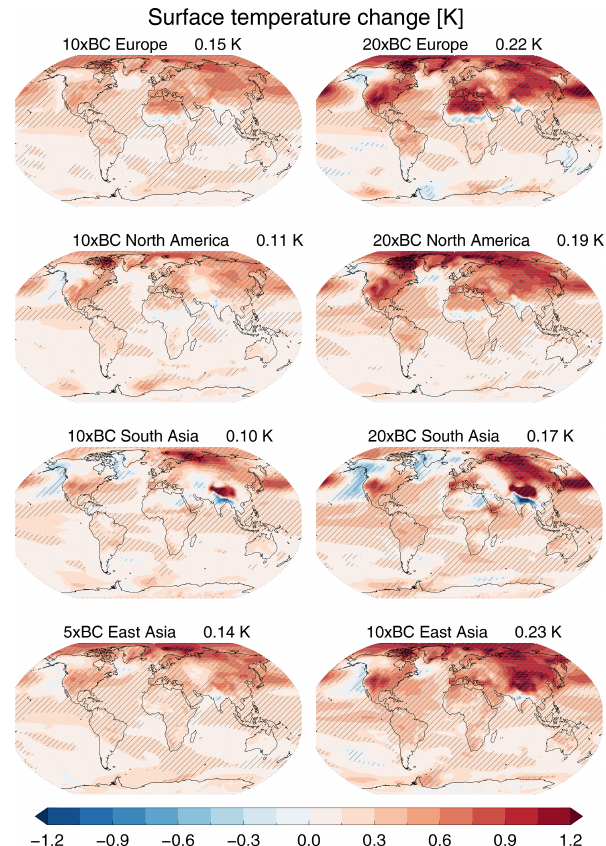
Figure 1. Surface temperature change (in K) for the perturbed runs minus the baseline. The emission region is given in each panel (from top: Europe, North America, South Asia, East Asia). In the right- hand side column the emission rate is doubled compared to the left- hand side column. The stippled areas represent statistically signifi- cant changes ( p< 0 .